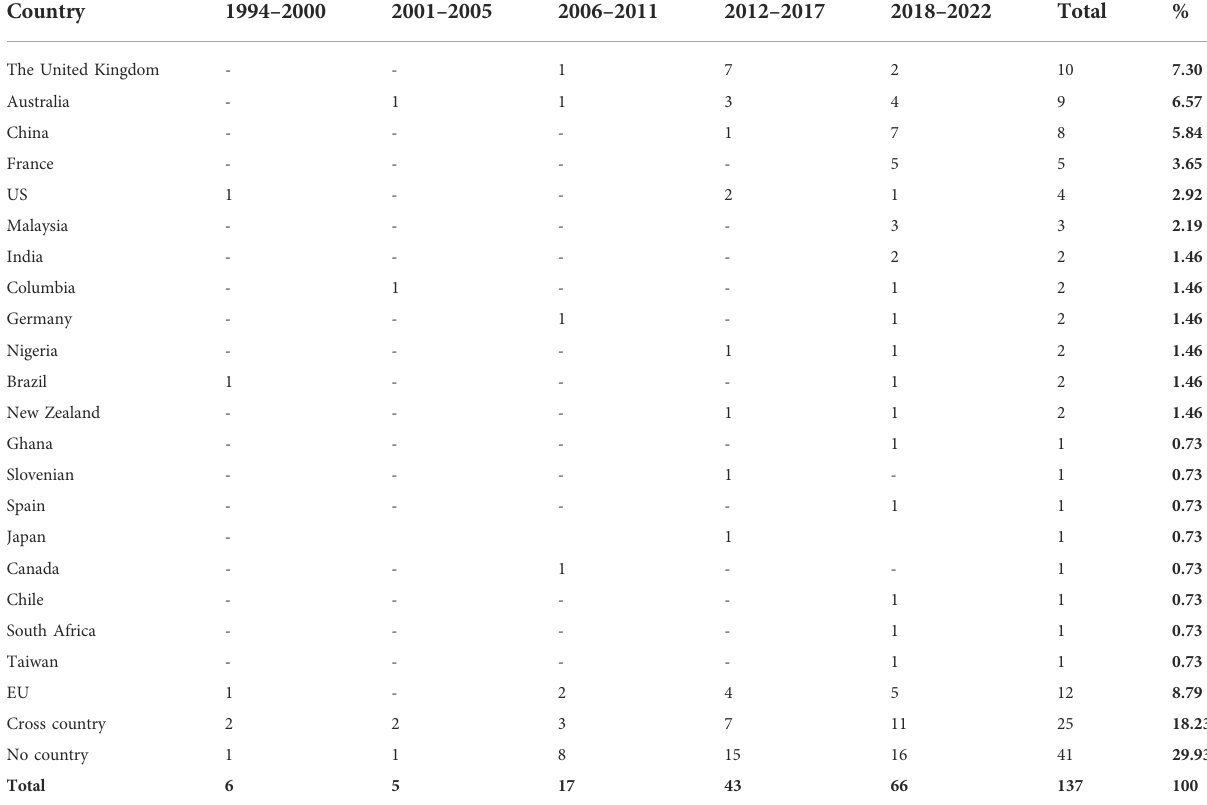
TABLE 1 Literature distributed by